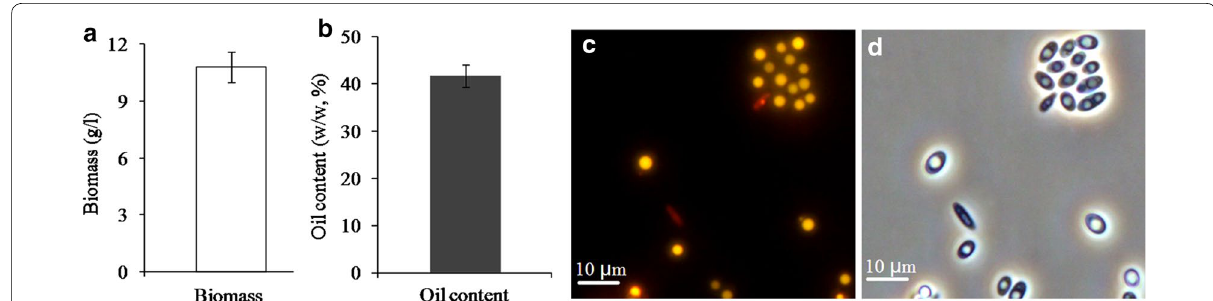
Fig. 1 Cell mass, oil content and lipid particles of the yeast strain ACA-DC 50109. a Biomass of the yeast strain. Data are given as mean b Oil content of the yeast strain. Data are given as mean